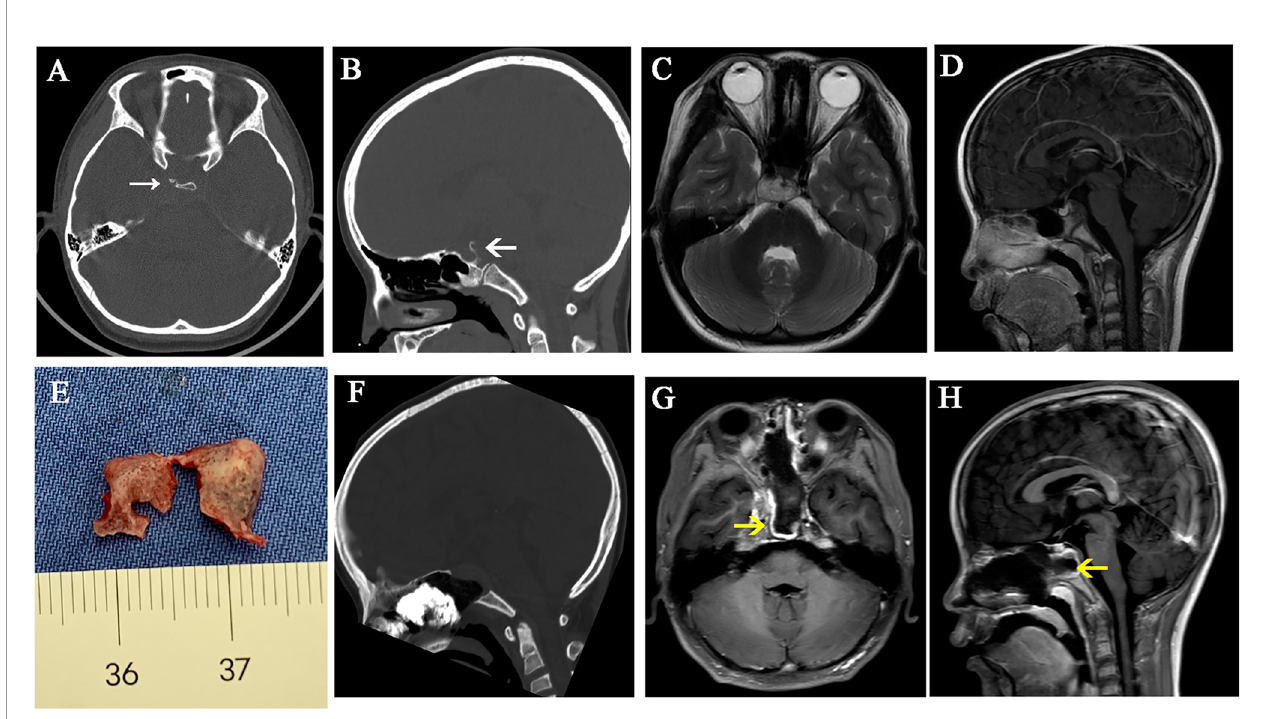
clinoid processes. (F – H) Postoperative CT and MR images show that the dorsum sellae and posterior clinoid processes were removed. The white arrows represent the eroded dorsum sellae and posterior clinoid processes. The yellow arrows represent the vascularized nasal septal fl